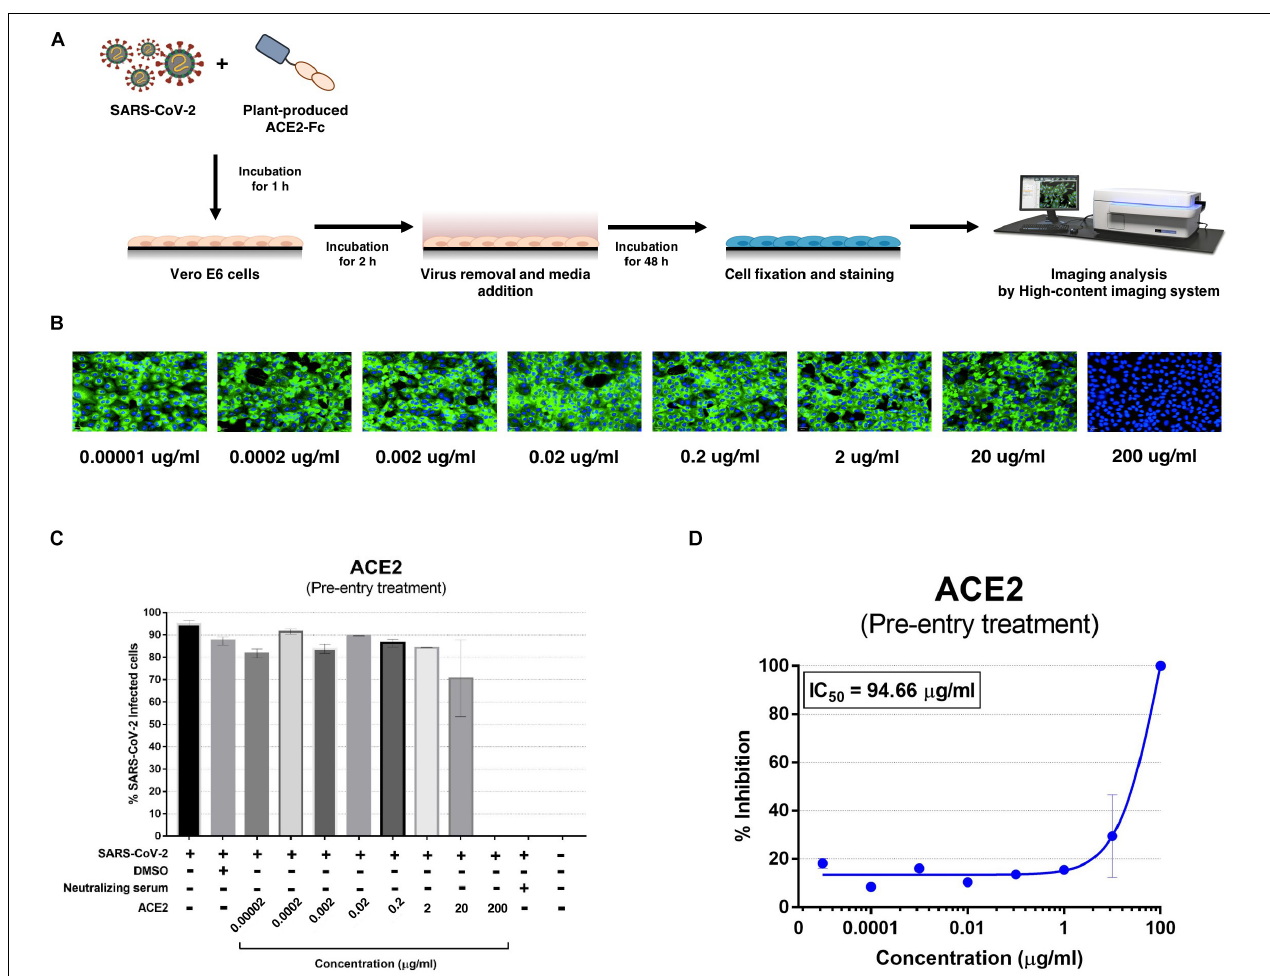
FIGURE 5 | Dose-dependent effect of plant-produced ACE2-Fc on SARS-CoV-2 inhibition and neutralization at the pre-infection phase. Experimental design of plant-produced ACE2-Fc and SARS-CoV-2 mixture added to Vero E6 cells (at 25TCID 50 ) (A) . SARS-CoV-2 infection profiles in Vero E6 cells which were treated with eight concentrations of plant-produced ACE2-Fc (B) . Percentage of SARS-CoV-2 inhibition in Vero E6 cells, which were treated with eight concentrations of plant-produced ACE2-Fc starting with 200 µ g/ml (C) . Efficacy of SARS-CoV-2 inhibition in Vero E6 cells, which were treated by eight concentrations of plant-produced ACE2-Fc (D) . The data were showed as mean ± SD of triplicates in individual